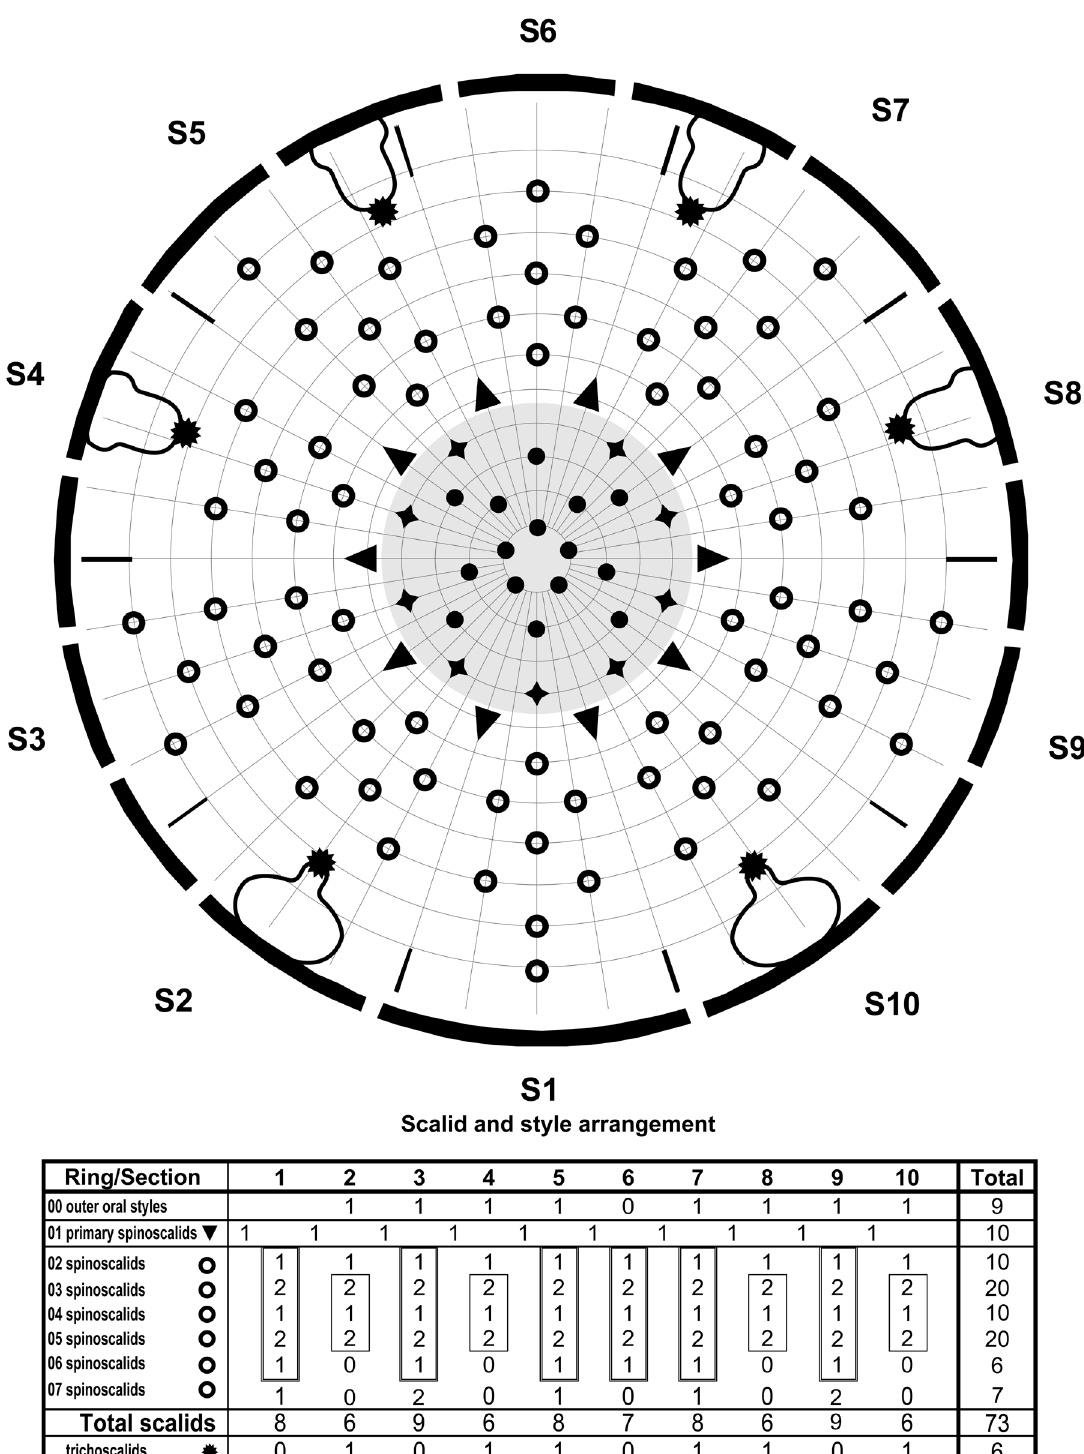
Fig. 3. Diagram of mouth cone (grey area), introvert and placids in Echinoderes dujardinii Claparède, 1863, showing distribution of inner oral styles (full circles), outer oral styles (diamonds), primary scalids (triangles), spinoscalids (thick open circles), and trichoscalids (stars), with positions of trichoscalid plates and placids indicated. Table shows the scalid arrangement by sector; single-lined boxes mark quincunxes, double-lined boxes mark ‘double